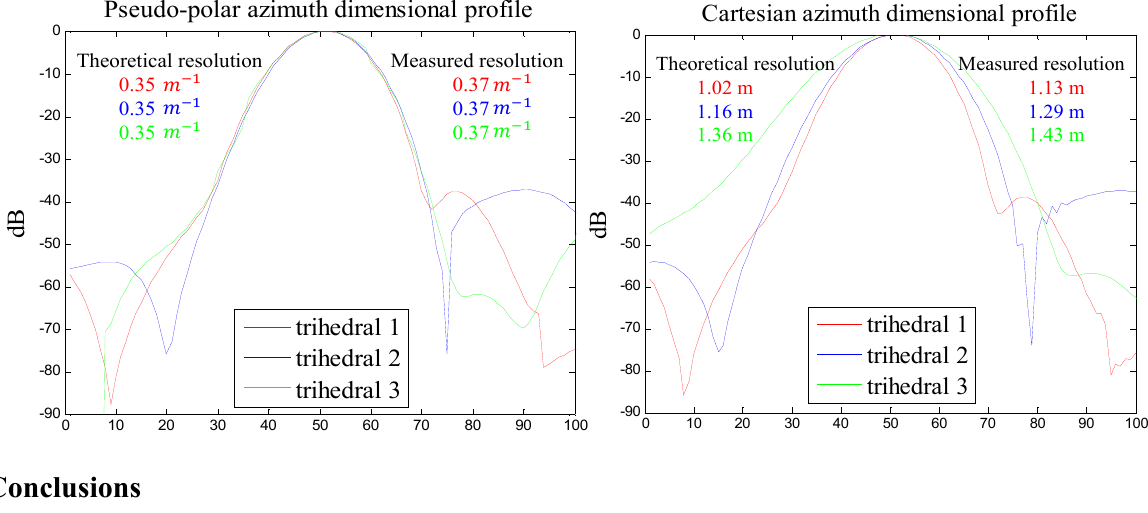
Figure 13. The trihedral angle reflector azimuth resolution comparison in the pseudo-polar and Cartesian